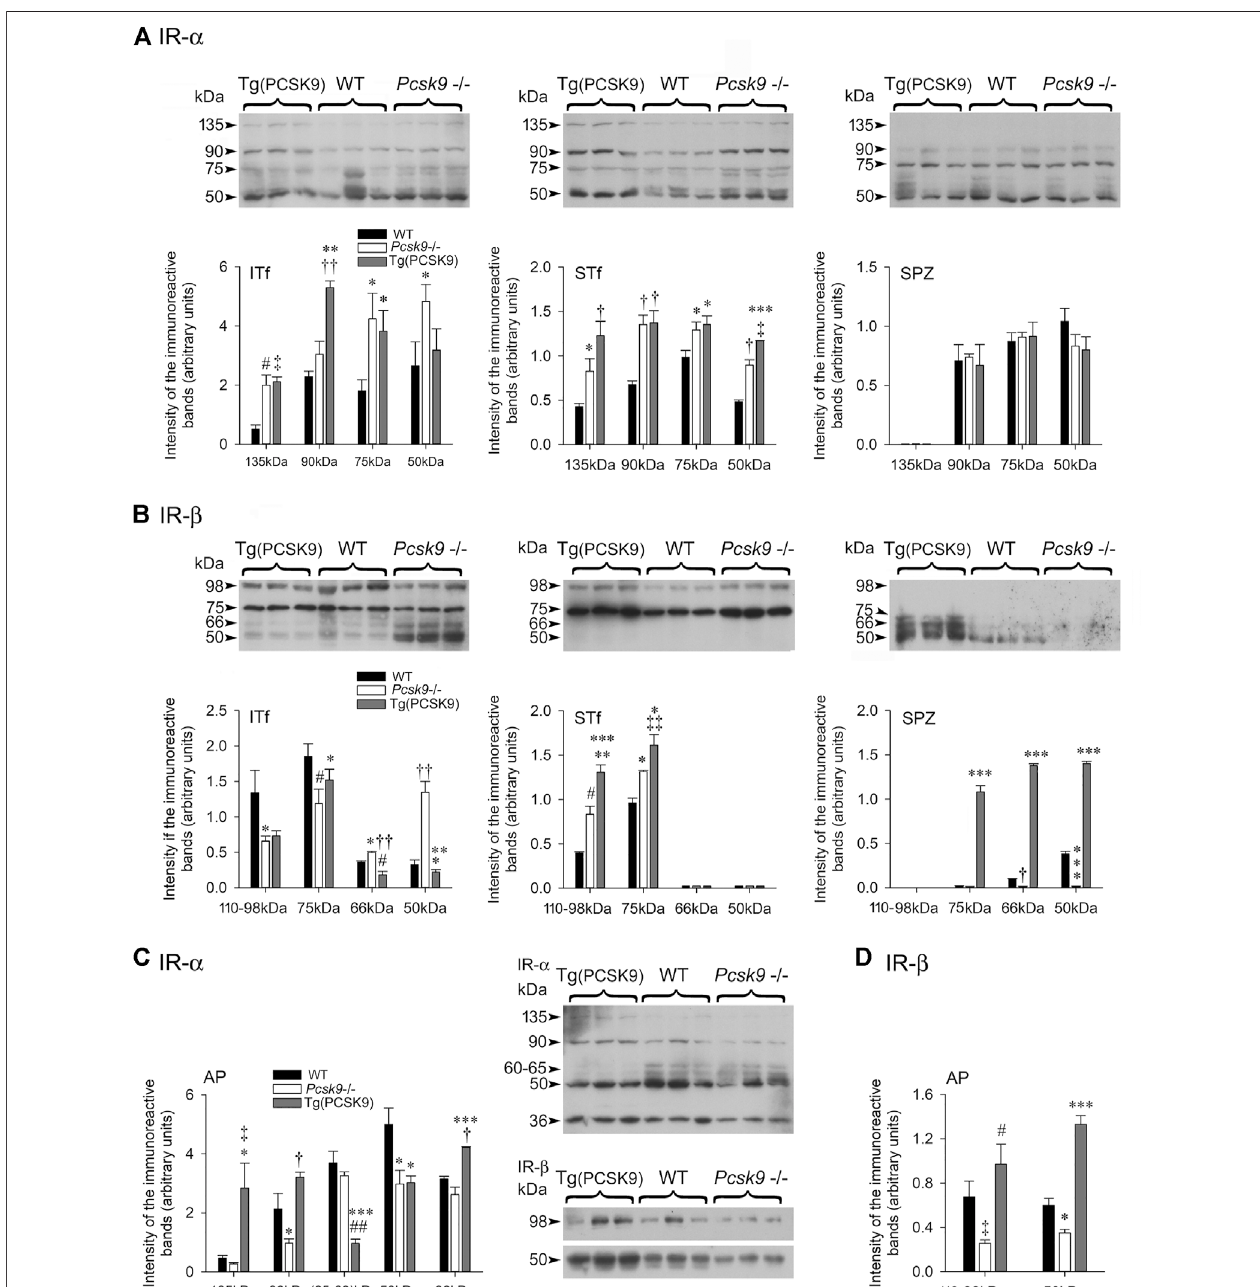
FIGURE 6 | (A,C) Insulin receptor (IR)- α and (B,D) Insulin receptor (IR)- β subunits in (A,B) ITf, STf and SPZ and (C,D) anterior pituitary (AP). Representative immunoblots with corresponding histograms of IR subunits α and β protein levels are shown. The values are the mean ± SEM; n = 3 per experimental group. (A) IR- α subunit:ITf:In Pcsk9 − / − mice,theincreasesin135-( # p < 0.02),75-(* p < 0.05)and50 kDa(* p < 0.05)IR- α levelsaresigni fi cantcomparedtoWT.InTg(PCSK9)mice,the 135-( ‡ p < 0.03),90-( †† p < 0.001)and75 kDa(* p < 0.05)IR- α levelsaresigni fi cantlydifferentfromWT.Inaddition,inTg(PCSK9),90-(** p < 0.005)and75 kDa(* p < 0.05)levelsaresigni fi cantlydifferentfrom Pcsk9 − / − mice.STf:theincreasein135-(* p < 0.05),90-( † p < 0.01),75-(* p < 0.05)and50 kDa( † p < 0.01)IR- α in Pcsk9 − / − mice issigni fi cantcompared toWT.InTg(PCSK9)mice,theincrease in135- ( † p < 0.01),90-( † p < 0.01),75-(* p < 0.05) and50 kDa(*** p < 0.0005) issigni fi cantcompared to WT mice. 50 kDa fragment levels are also signi fi cantly higher in Tg (PCSK9) ( ‡ p < 0.03 vs. Pcsk9 − / − mice). SPZ: No differences in IR- α levels are observed amongst the experimental groups. (B) IR- β subunit: ITf: The differences in 110 – 98- (* p < 0.05), 75- ( # p < 0.02), 66- (* p < 0.05) and 50 kDa ( †† p < 0.001) IR- β levels between Pcsk9 − / − and WT mice are signi fi cant.In Tg(PCSK9) mice,66-( # p < 0.02) issigni fi cantlylowercomparedtoWT; 75-(* p < 0.05), and 66-( †† p < 0.001) and 50 kDa (*** p < 0.0005) levelsdiffersigni fi cantlyfrom Pcsk9 − / − mice.STf:the110 – 98-( # p < 0.02)and75 kDa(* p < 0.05)IR- β levelssigni fi cantlyincreasein Pcsk9 − / − micecomparedtoWT.InTg (PCSK9) mice, 110 – 98- (*** p < 0.0005) and 75 kDa ( ‡‡ p < 0.003) signi fi cantly differ from WT and 110 – 98- (** p < 0.005) and 75 kDa (* p < 0.05) signi fi cantly differ from Pcsk9 − / − mice.SPZ: In Pcsk9 − / − ,66 kDa( † p < 0.01)and 50 kDa(*** p < 0.0005)IR- β levelsaresigni fi